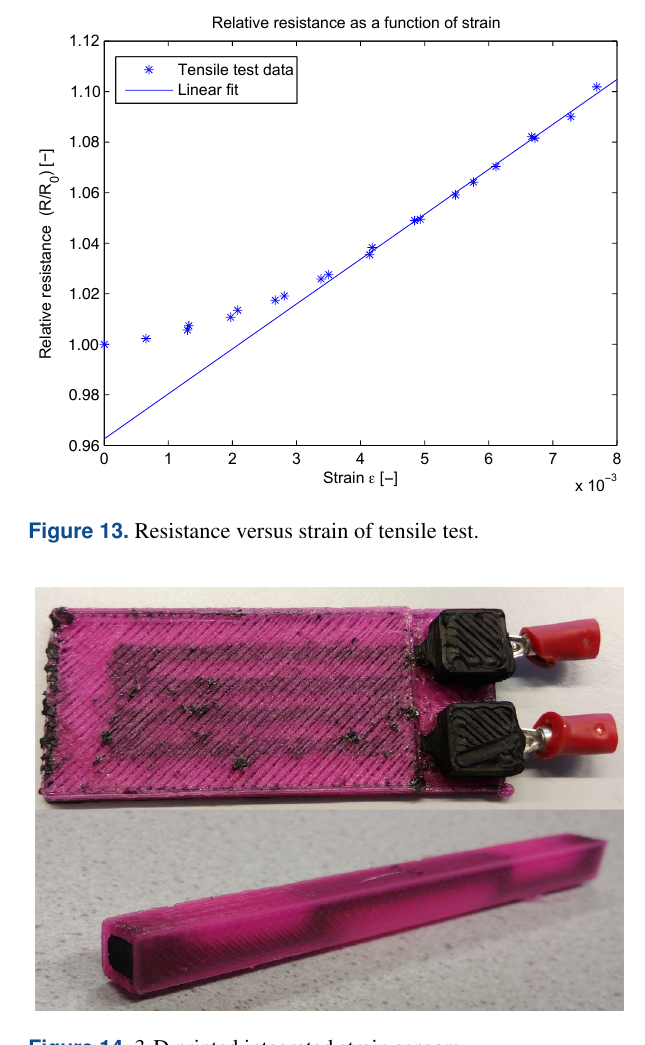
Figure 14. 3-D printed integrated strain sensors.